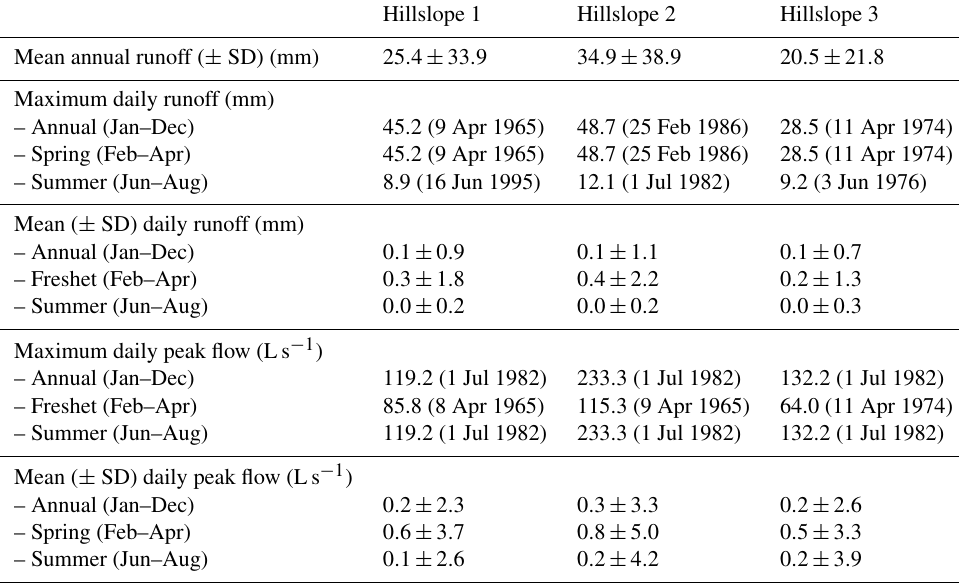
Table 3. Summary statistics of runoff data.